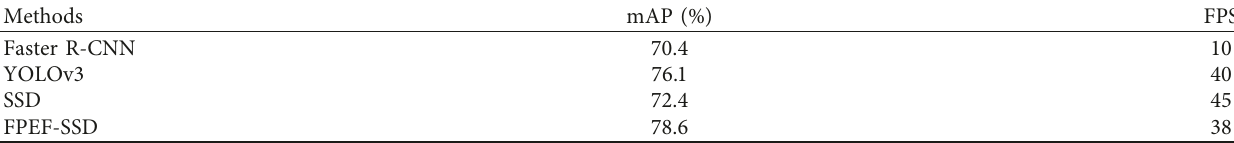
Table 4: Comparison of mAP and FPS results of Pascal VOC